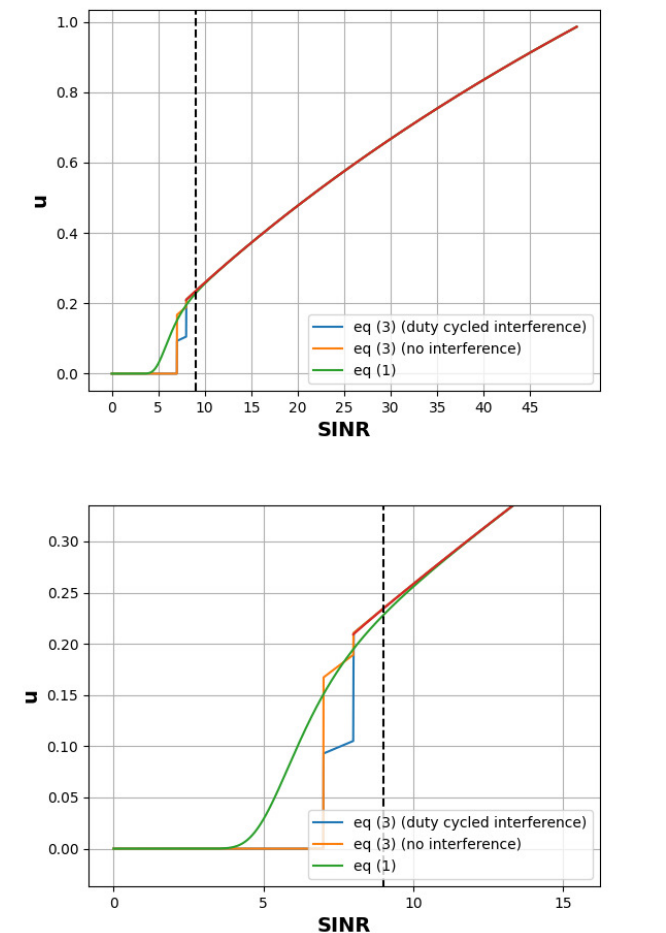
Figure 5. Utility as a function of SINR γ i , j